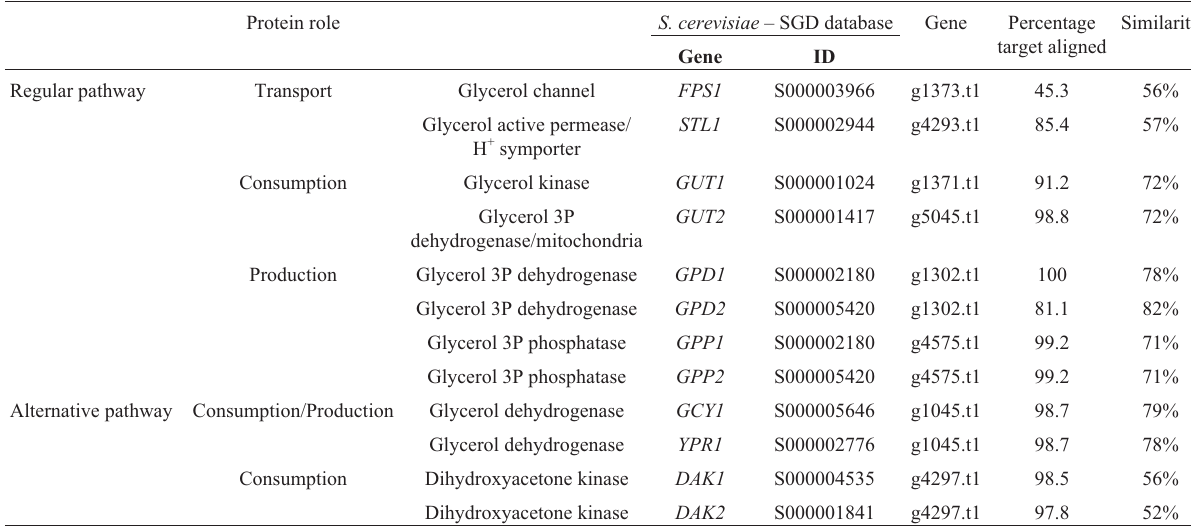
Table2 - Similaritybetweenthe S.cerevisiae genesencodingtheproteinsresponsibleforglyceroltransportandmetabolismasinFigure1,andthecorre- sponding